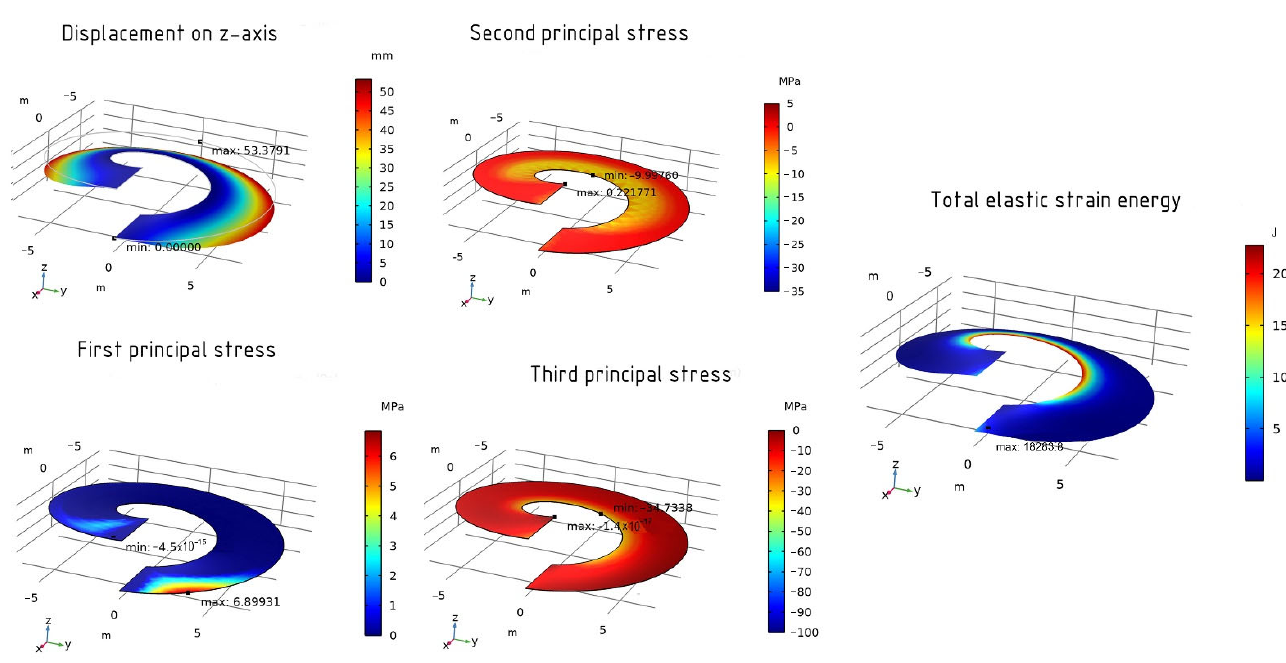
Figure 8. The structural analysis of the helicoid shell (finer element size). Next, the mesh type is changed from «fine» to «finer» (Figure 9) and the model is split into 264 triangles. The maximum element size is 1.14 m and the minimum element size is 0.143 m.